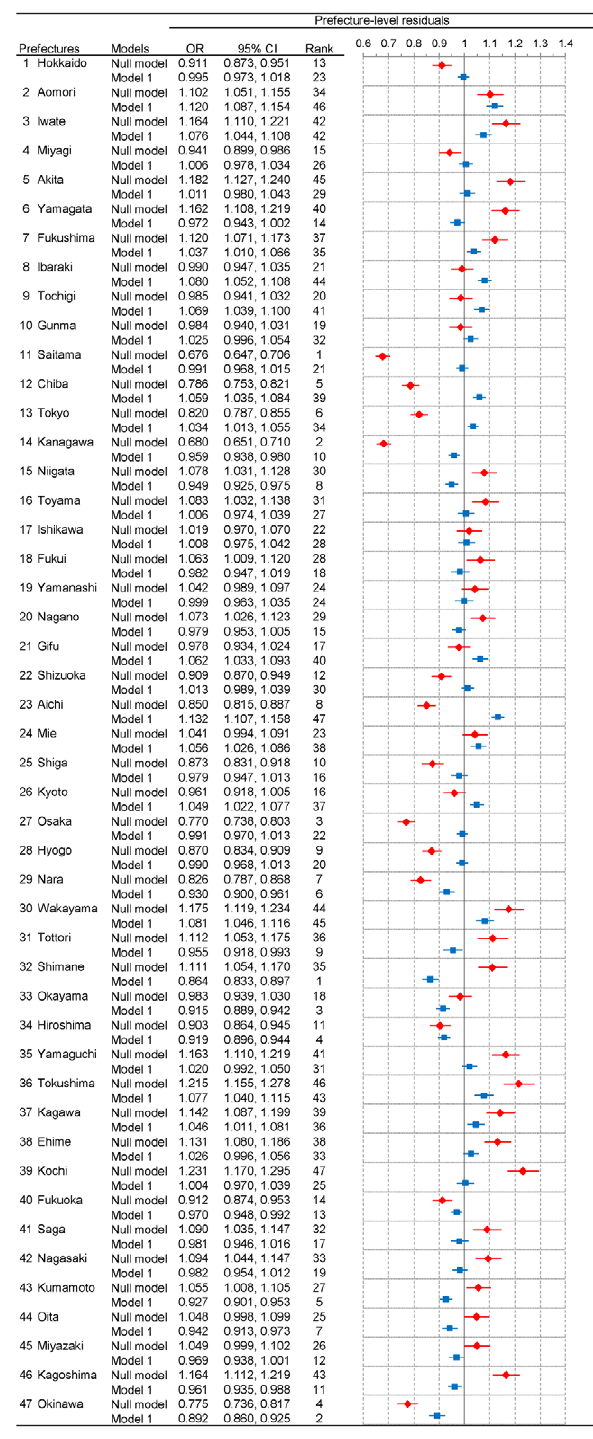
Figure 3. Unadjusted and adjusted prefecture-level residuals for all-cause mortality among women in 47 prefectures, Japan, 2005. Prefecture-level residuals are described in odds ratios with the reference being the grand mean of all prefectures. Red diamond and blue square represent point estimates of residuals from null model and model 1, respectively. Horizontal bars represent their 95% credible intervals. Prefectures with a lower estimate of odds for all-cause mortality are ranked higher. Note that CI and OR stand for credible interval and odds ratio, respectively.